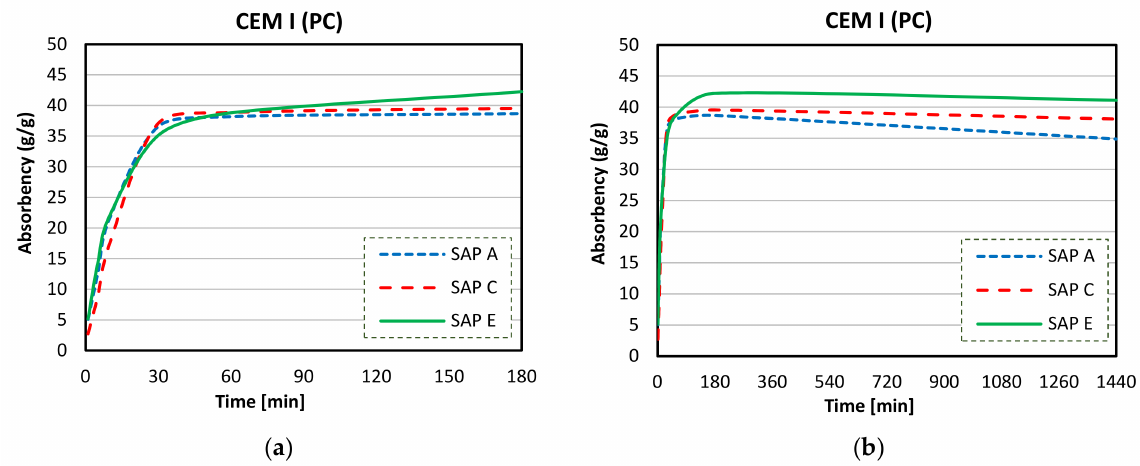
Figure 13. Sorption behaviour SAPs in CEM I (PC) up to 180 min ( a ) and up to 1440 min ( b ) [6]. Figure 14a,b present the results of SAPs absorbency in CEM II (PC-FA) solutions. Sim- ilar behaviour of SAP A and SAP C absorption was recorded compared to CEM I solution. WACs in CEM II (PC-FA) filtrate at 24 h were about 33, 37, and 46 g/g correspondingly for polymers A, C, and E. However, the max WACs registered were 37, 38, and 46, for SAPs A, C, and E, respectively.